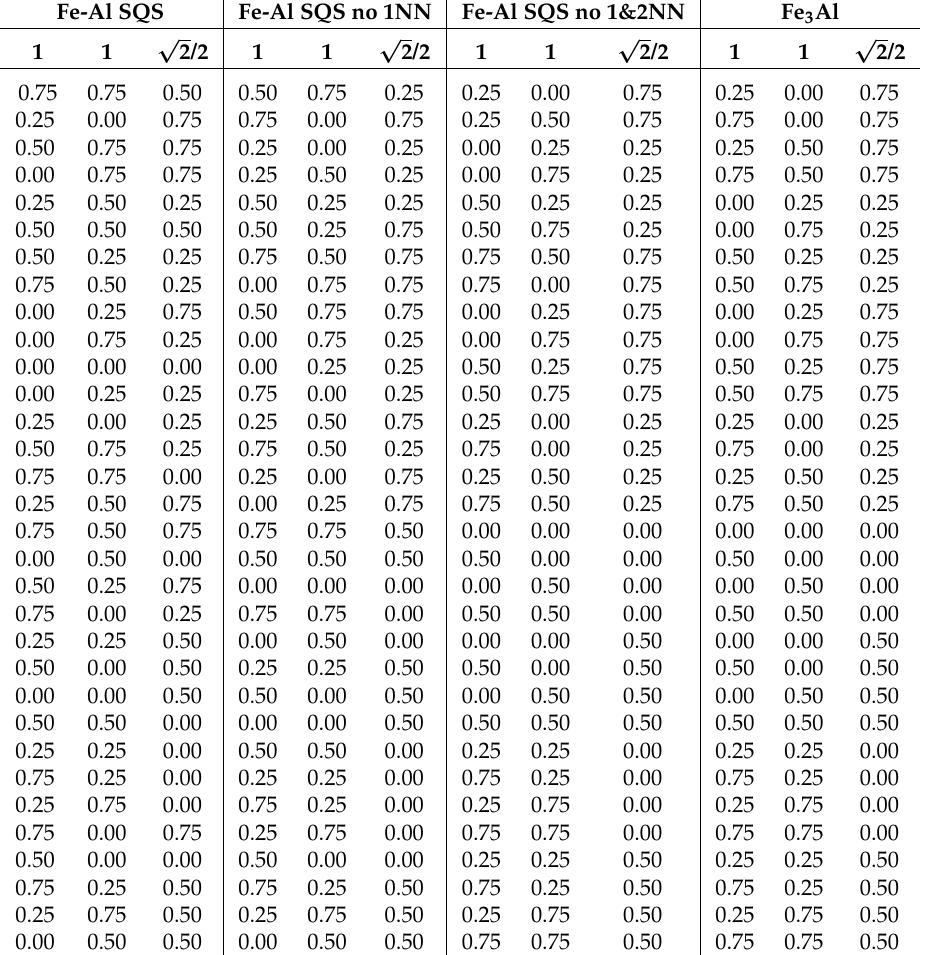
Table A1. Atomic positions (expressed as fractions of supercell dimensions) within the computational supercells shown in Figure 1. Aluminium positions are the first six rows in the case of Fe-Al variants and the first eight rows in the case of Fe 3